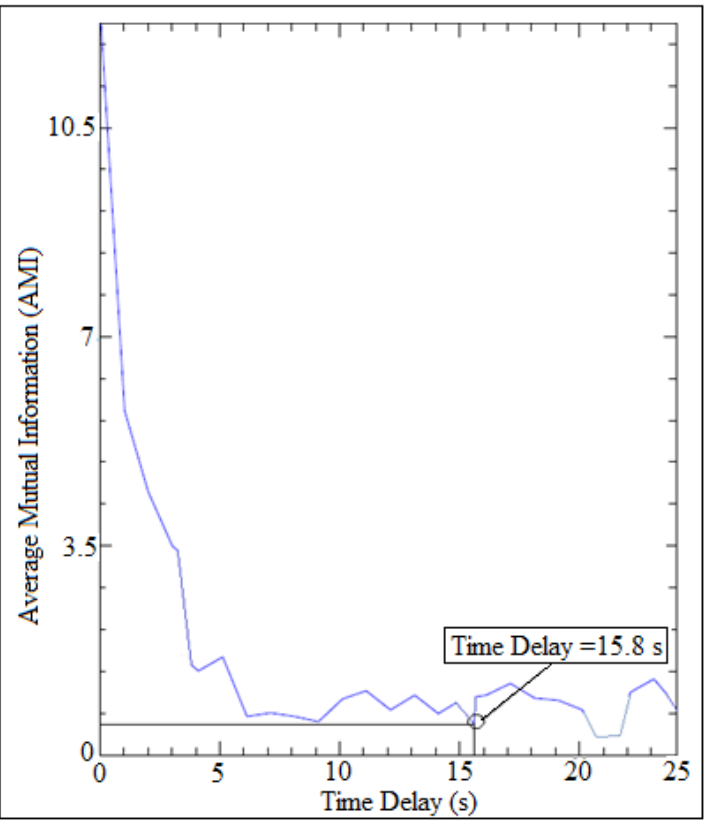
Figure 19. Time delay of numerical simulation.